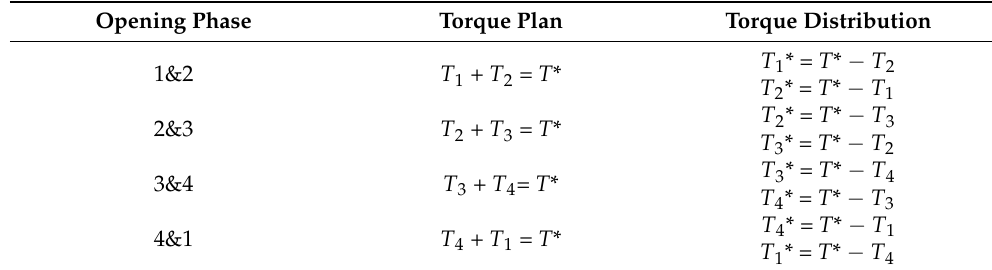
Table 1. Simple torque online